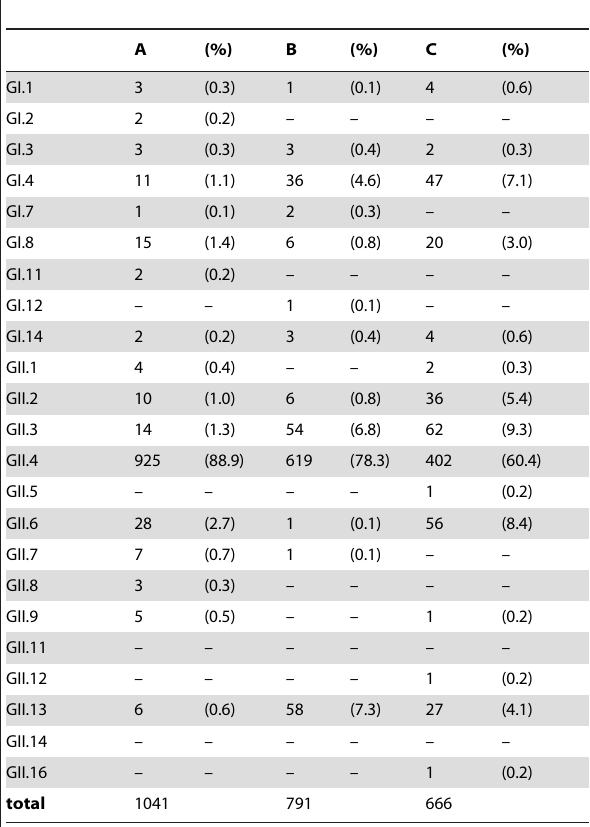
Table 1. Distribution of norovirus genotypes in 2006 (A), 2007 (B), and 2008